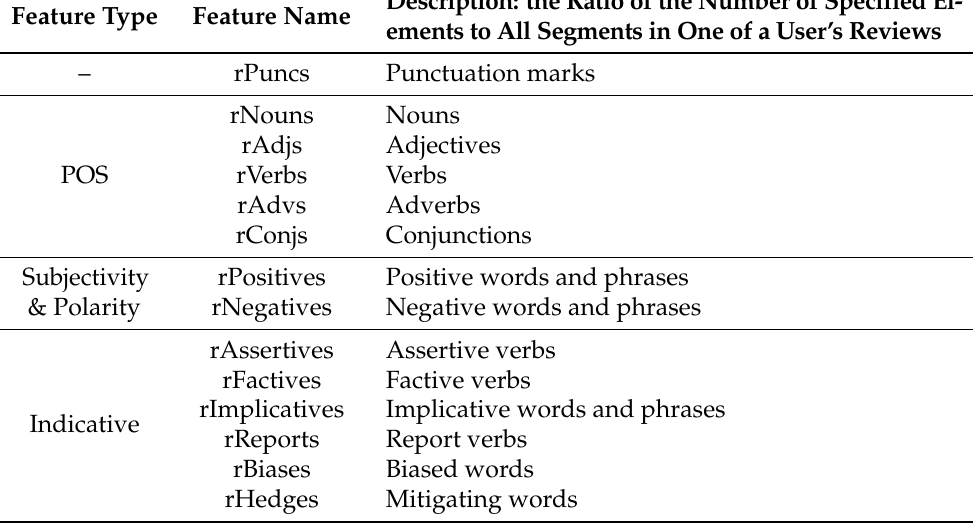
Table 4. Linguistic and stylistic features for reviews used in the proposed